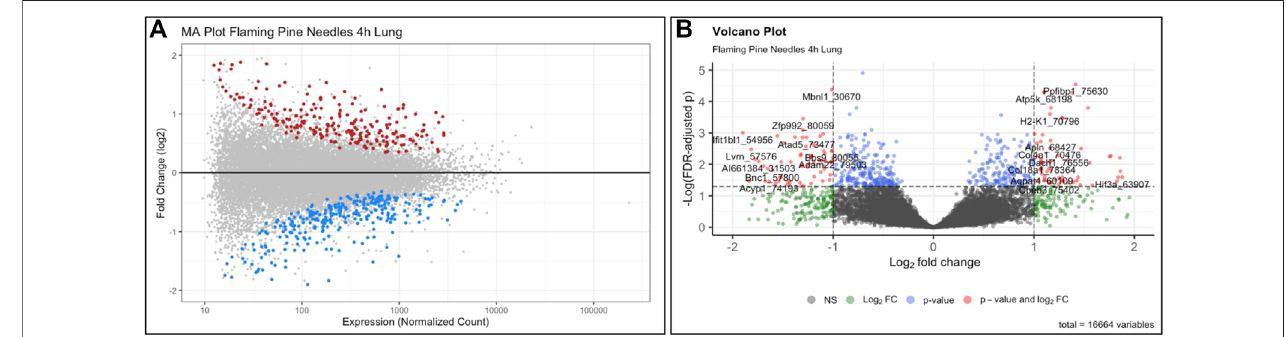
FIGURE6| Example (A) MAplotand (B) volcanoplotillustratingchangestothetranscriptomeoccurringfromexposure tothewild fi re-relevantexposurecondition of fl aming pine needles, identi fi ed through this training module. Here, each individual dot represents a gene that was queried for via transcriptome technologies, color- coded according to level of signi fi cance (multiple test corrected p -values) in association with exposure vs. control conditions within the mouse lung. Grey dots indicate genesthat were not signi fi cant ( p > 0.10),and colored dots indicate genes thatweresigni fi cant( p < 0.10). Dots ofsigni fi cant genes were further colored according tofoldchange(ratiosofaverageexposed/unexposedsamples),withredindicatingpositivefoldchangevalues(i.e.,exposure-associatedincreasedexpression)andblue indicating negative fold change values (i.e., exposure-associated decreased expression) for the MA plot. For the volcano plot, colors indicate different fi lters that were implemented to identify levels of gene expression changes. Expression levels, fold change, and p -values are used to visualize the distribution of these statistical results produced from this example -omics